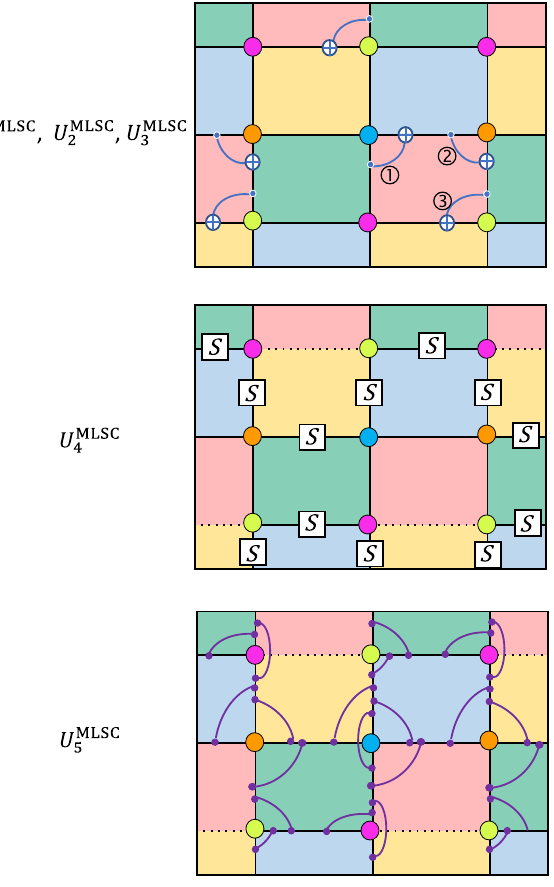
FIG. 19. The finite-depth Clifford circuit for the MLSC to the exact bosonization. The first Clifford circuit will disentan- gle the qubits on the edges between red and yellow faces, so the edges between red and yellow faces become dashed lines in the second and third steps. The first panel involves , U MLSC , U MLSC corresponding to the three unitary circuits U MLSC 1 2 3 controlled- NOT ( CNOT ) gates labeled 1 (cid:2) , 2 (cid:2) , and 3 (cid:2) , respec- tively. The finite-depth Clifford circuit that converts Majorana- loop stabilizer codes to the exact bosonization is U MLSC